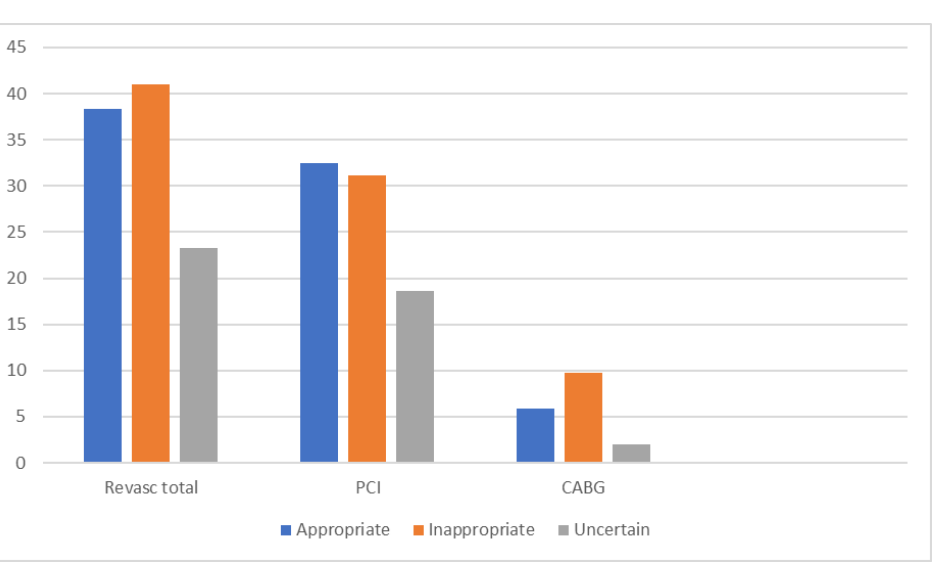
Figure 3. Total revascularization split in percutaneous coronary intervention (PCI)/coronary artery bypass graft (CABG) . Abbreviations: CABG — coronary artery bypass graft, PCI — percutaneous cor- onary intervention . The total revascularization rate was 39.2%, of which were 79.5% PCI and 20.5% CABG, without significant differences between the groups ( p value = 0.071). Interestingly, coronary revascularization rates did not differ significantly between the appropriate and the inappropriate groups (38.3% vs. 41%, p = 0.068). The rates of per- cutaneous coronary interventions were similar; the rate of CABG was higher in the inap- propriate group.